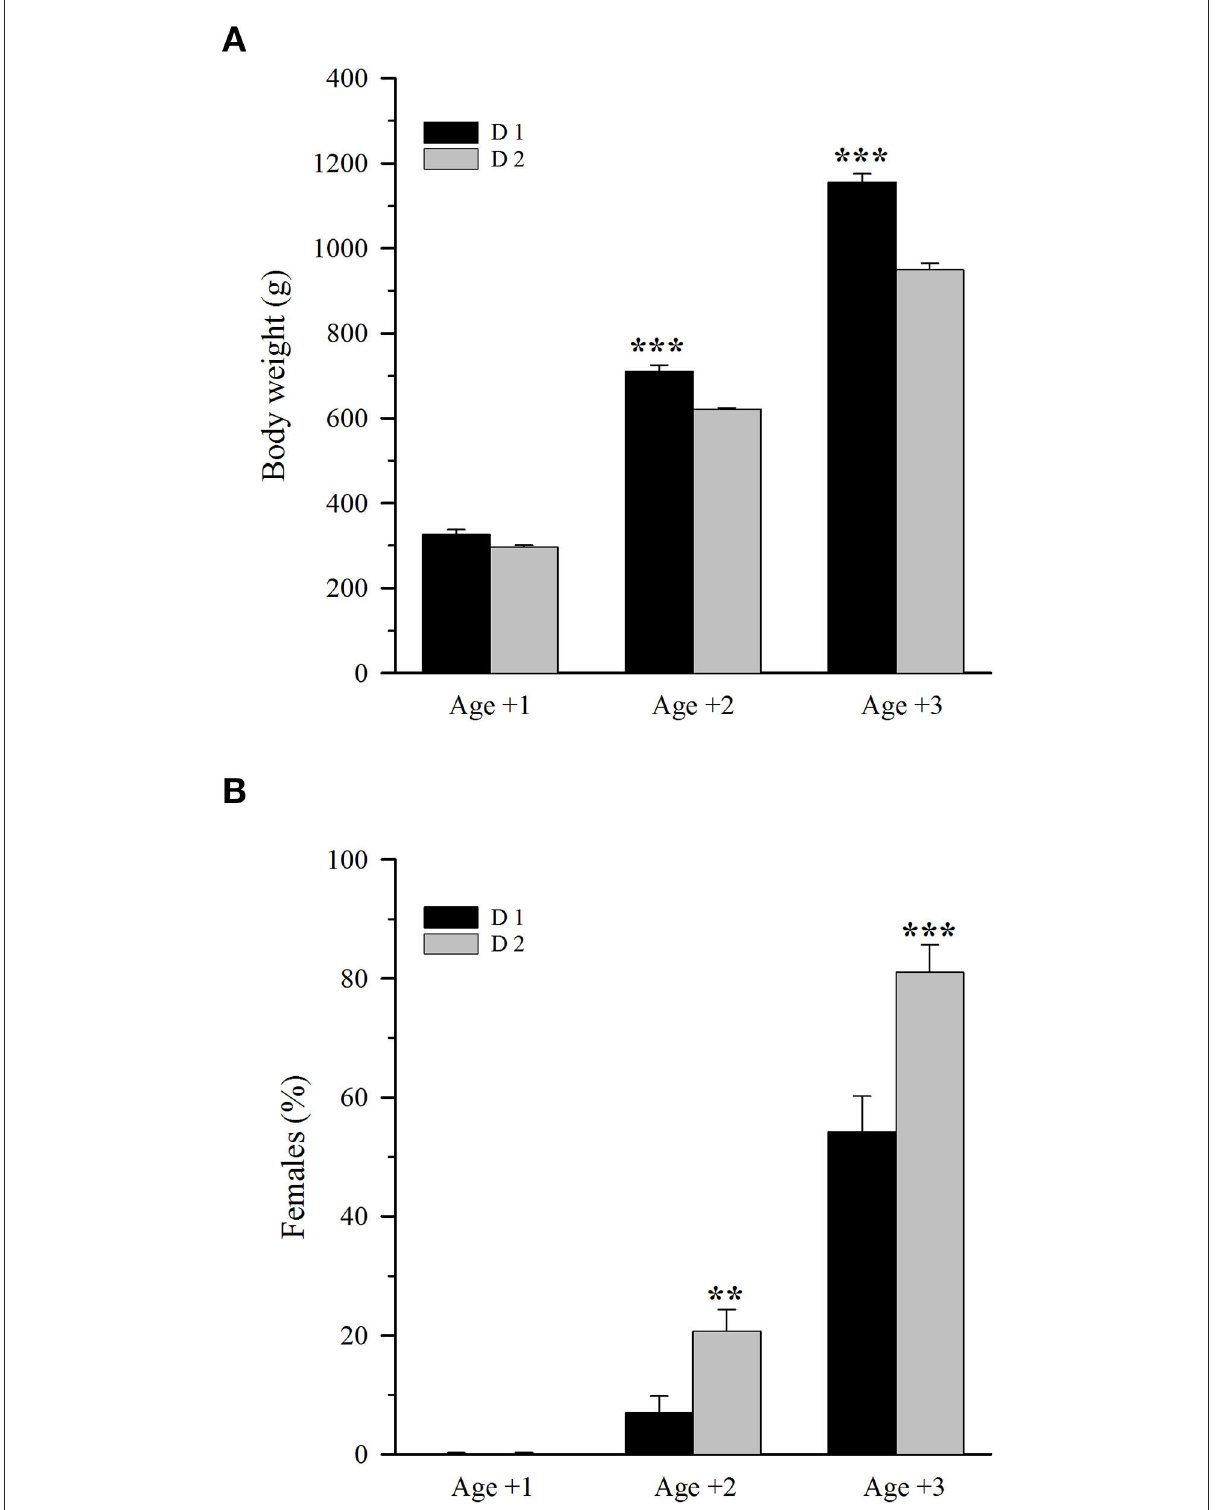
FIGURE1 (A) Body weight and (B) female percentage in 1-, 2-, and 3-year-old gilthead sea bream fed an FM/FO diet (D1) or a plant-based diet (D2). Values are the mean ± SEM of three tanks per diet ( n = 261 (D1) − 271 (D2) fish/diet at Age + 1, 202 (D1) − 207 (D2) fish/diet at Age + 2, 138 (D1) − 146 (D2) fish/diet at Age + 3). Asterisks indicate significant differences between the experimental diets within each age (Student’s t -test, ** P < 0.01, *** P <